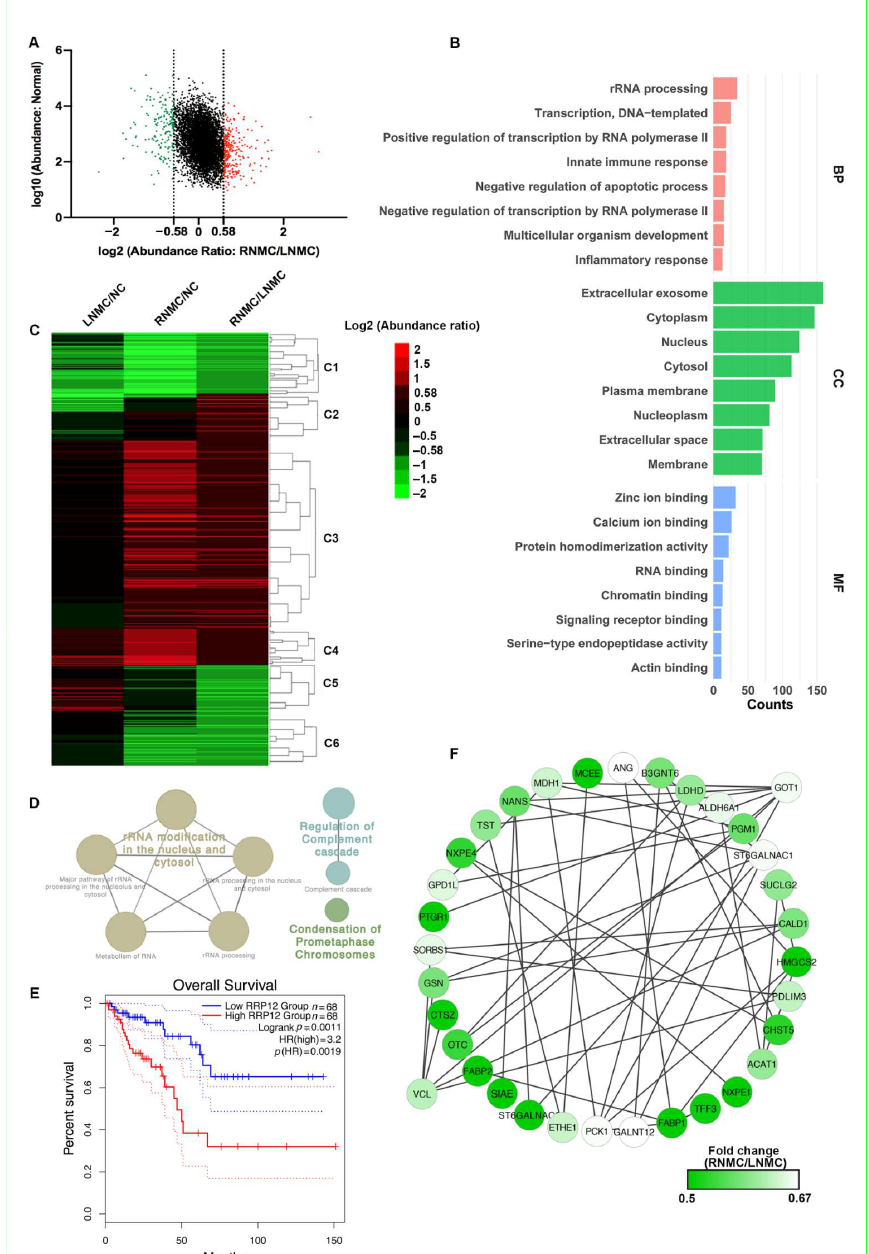
Figure 2. Functional analysis of differentially expressed proteins (DEPs) between RNMC and LNMC tissues. ( A ) Scatter plot showing the distribution of upregulated (red dots) and downregulated (green dots) DEPs. ( B ) GO analysis indi- cated enrichment of these DEPs in biological processing (BP), cellular component (CC), and molecular function (MF). ( C ) Hierarchical clustering analysis and heatmap of DEPs. The heatmap was constructed based on a log2 transformation of relative abundance ratios (RNMC/LNMC). ( D ) REACTOME pathway analysis of the RNMC-specific upregulated DEPs. ( E ) The Kaplan–Meier survival analysis indicated inferior overall survival among colon cancer patients with high RRP12 expression. ( F ) The RNMC-specific downregulated DEPs in the protein–protein interaction networks are shown as nodes (MS data presented as the 131/130 ratios were matched to STRING networks). The intensity of the green color indicates the ratio of protein abundance in RNMC/LNMC. The protein abundance of tumor tissue relative to normal tissue is indicated in different colors, with red indicating up-regulated protein and green indicating down-regulated